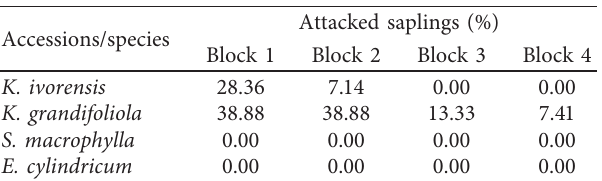
Figure 7: Schematic layout of the trial sites for the Meliaceae species blocks. Table 3: Percentage of saplings attacked by H. robusta in various blocks of the Meliaceae species trials in the moist semideciduous forest types in the 12 th